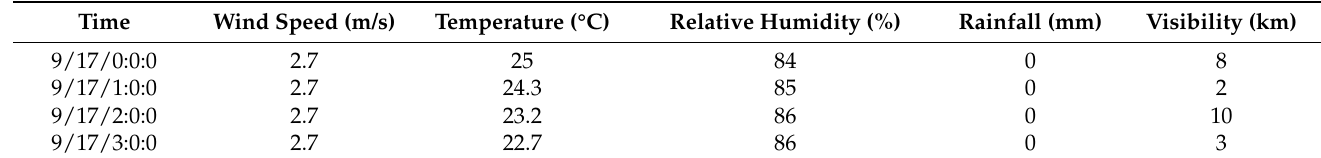
Table 1. The data in the external environment section indicates.